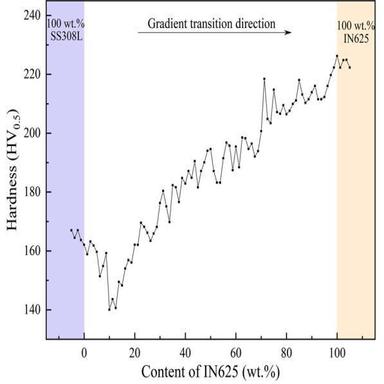
The variation trend of microhardness of the FGM with the change in IN625.